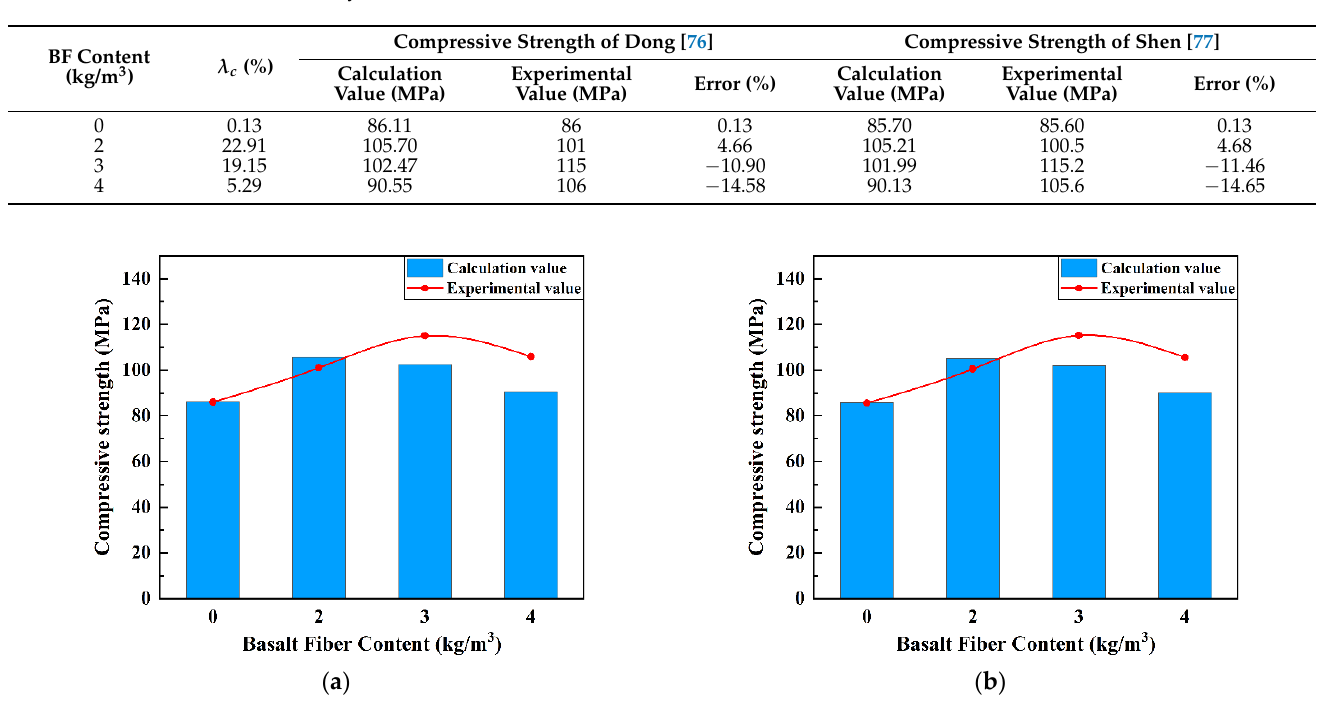
Figure 17. The experimental results of ( a ) Dong [76] and ( b ) Shen [77] were compared with those calculated by the calculation formula.